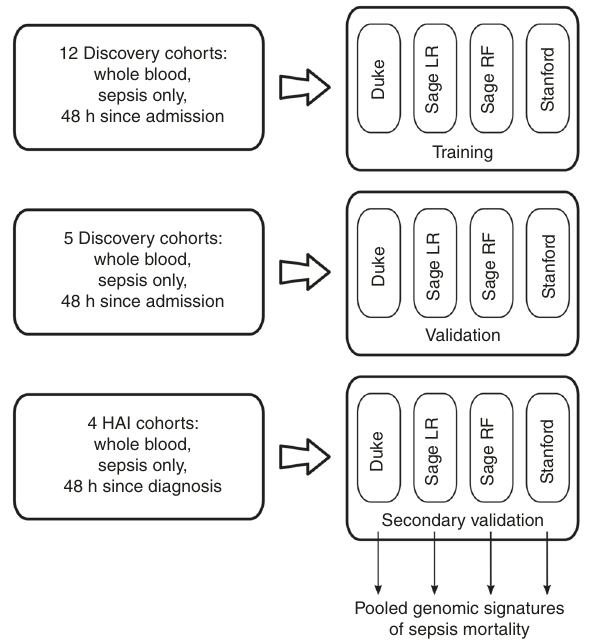
Fig. 1 Overview of analysis: schema of our community-modeling-based approach to multi-cohort analysis. Three phases are shown, as described in the Methods section: (i) discovery, (ii) validation, and (iii) secondary